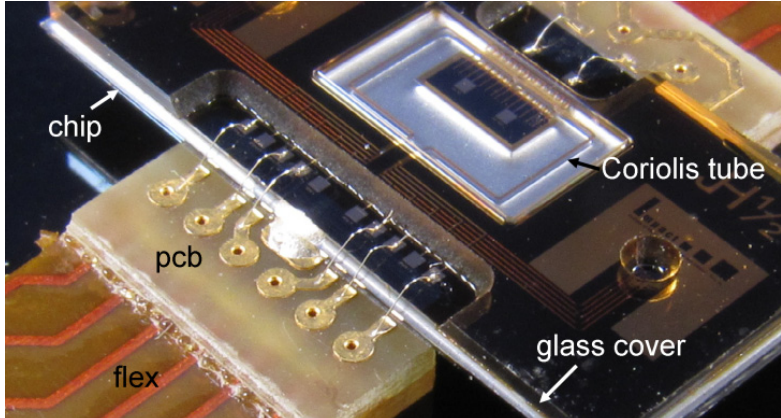
Figure 3. Micro Coriolis chip glued to a printed circuit board (PCB). Electrical connections to the PCB are made with